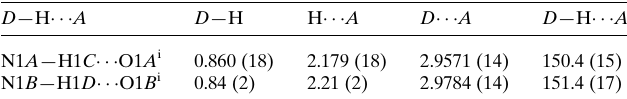
Table 1 Hydrogen-bond geometry (A˚ , (cid:3) ) for form 1.